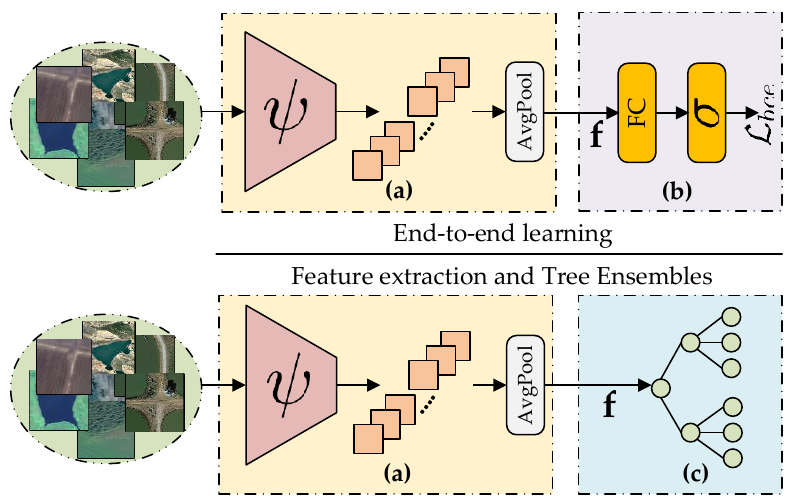
Figure 3. Overview of the proposed strategy for MLC of RSI. Part ( a ) of the strategy is the fully convolutional CNN backbone feature extractor. This part is same for both end-to-end learning, and feature extraction. The next part of the strategy, marked ( b ), is only used during end-to-end learning. The last part, marked with ( c ), is used for training tree ensemble methods from the extracted features, as a separate task and not a part of the end-to-end learning process. For this separate task the CNN feature extractor ( a ) is used in offline mode to generate the required feature representations, which serve as inputs to learn tree